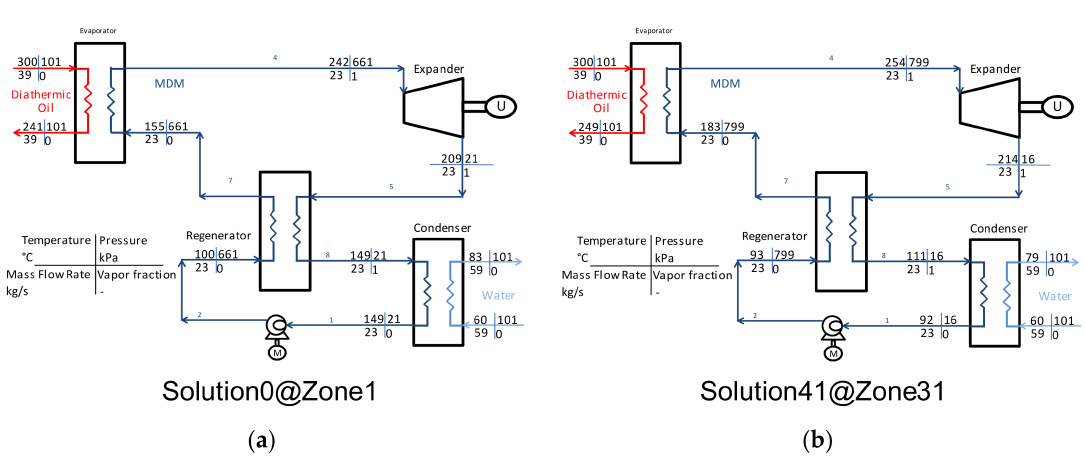
Figure 17. Scheme of the studied ORC power plant with details of the thermodynamic conditions